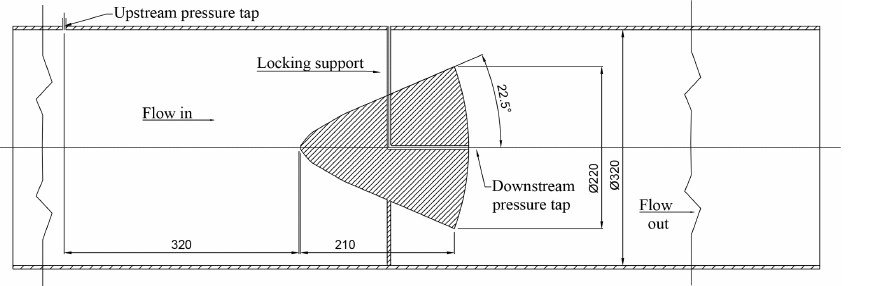
Figure 2. Schematic view of the proposed modified cone flowmeter.